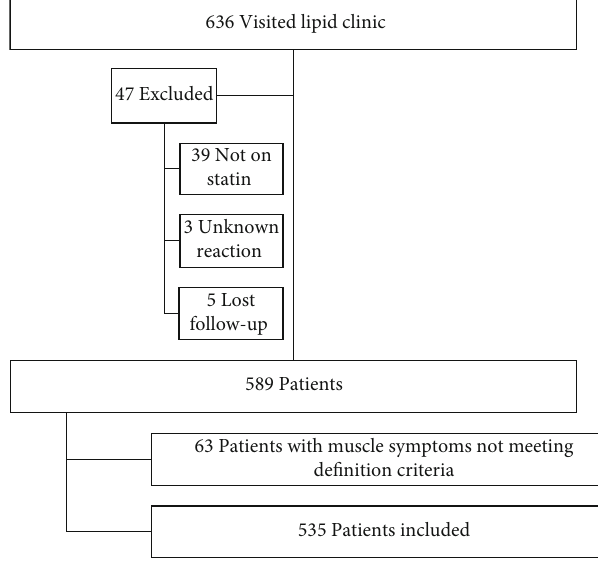
Figure 1: Flow chart of inclusion criteria. Table 1: Clinical and biochemical characteristics of study